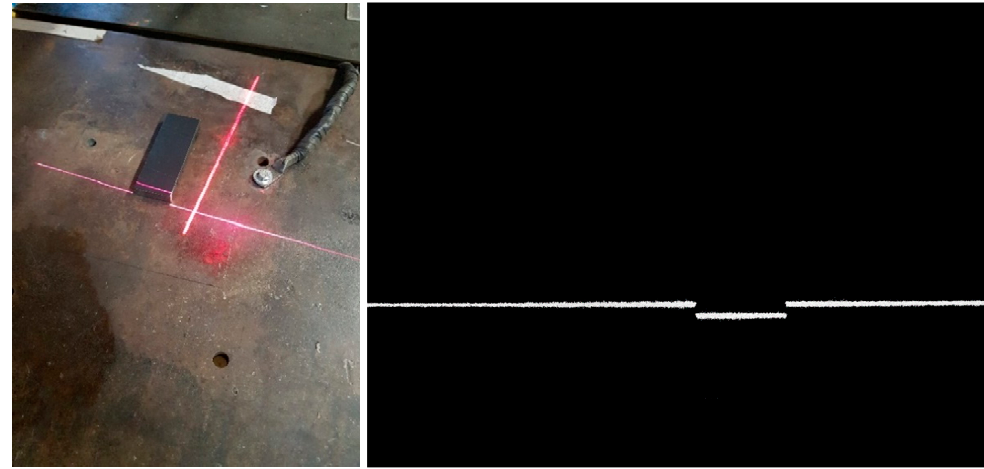
Figure 16. Image of the standard block and processed image data in a laser projector position.